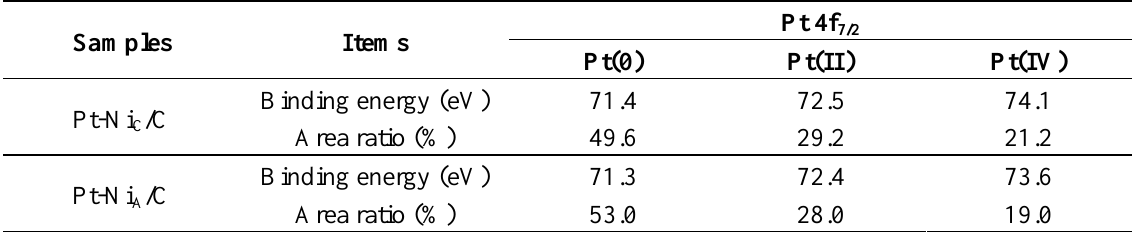
Table 1. Chemical States, binding energy, and area ratio of Pt-Ni catalysts by XPS.